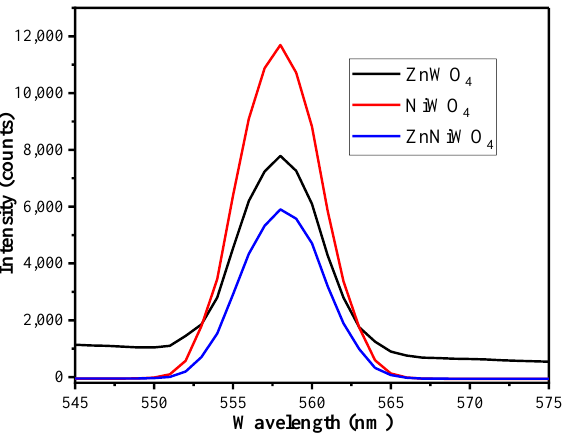
Figure 6. Photoluminescence (PL) spectra of ZnWO 4 , NiWO 4, and ZnNiWO 4 recorded at 320 nm excitation wavelength dispersed in methanol.